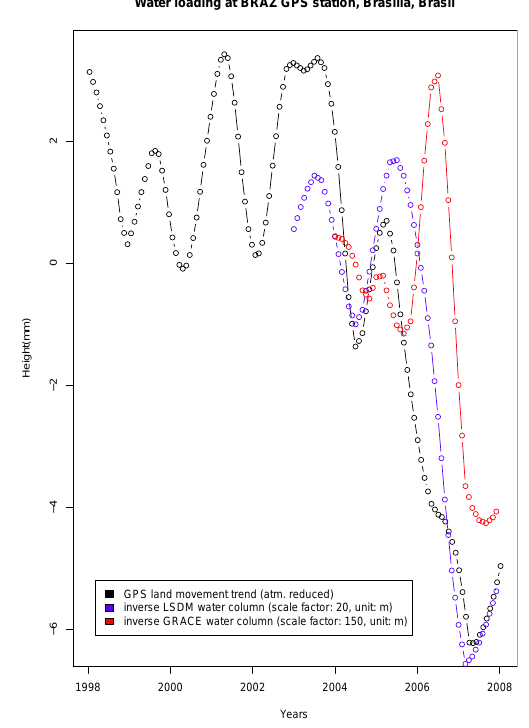
Fig. 15. A qualitative comparison of three different signals show- Fig. 10. The picture shows a qualitative comparison of three different signals showing the 2007 drought in Brazil: GPS land movement, (inverse)waterstoragemassand(inverse)hydrologicalloadingfromGRACE.TheGPSlandmovementsignalshowsaclearnegativetrend ing the 2006 drought in Brazil: height time series of GPS station from2006on,whichcanbeeasilyrediscoveredinboththeLSDMhydrologymodeland,withacertainlag,theGRACEdata. Thepicture showsthenonlineartrend(seasonalsignalandnoiseremoved)forallthreetimeseries. Brasilia (BRAZ), inverse water storage mass and inverse hydrolog- ical loading from GRACE data. The nonlinear trend (seasonal sig- nal and noise removed) is depicted in all three time series. Different scale factors are used for three